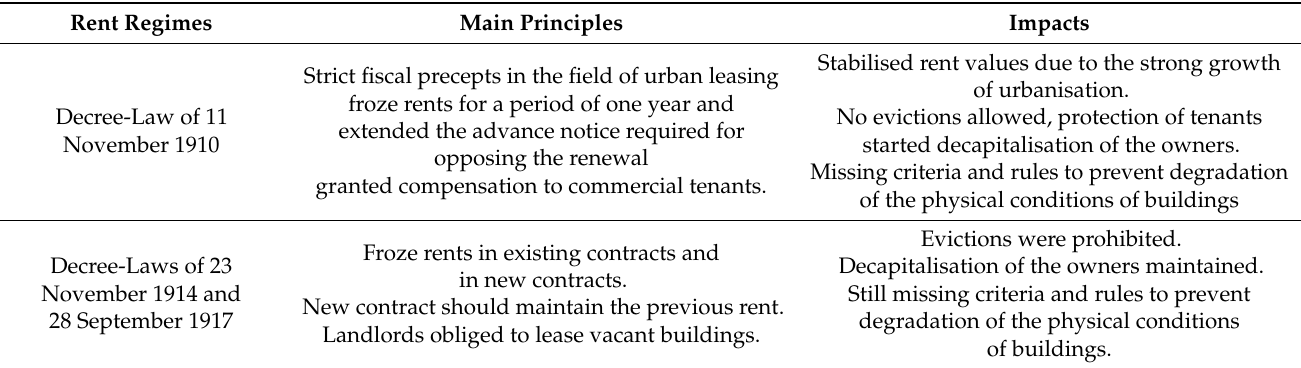
Table 1. Rent regimes in Portugal: characteristics and